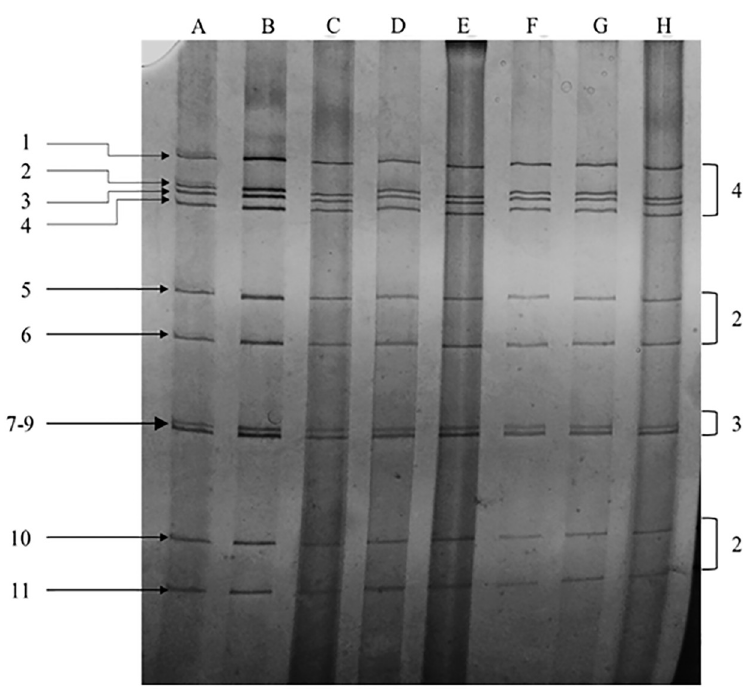
Fig 1. Electropherogram of rotavirus strains isolated from diarrhoeic calf samples in Bangladesh. 1–11, segments of RNA. The genomic RNA segments migration pattern of 4:2:3:2, typical of group A rotavirus was observed in polyacrylamide gel, where segments 7, 8, and 9 moved in a triplet. Segments 1–4, respectively, encode structural protein VP1-VP4, Segemnts 6 and 9 encode structural protein VP6 and VP7, respectively. Segments 5, 7, 8 and 10 encode nonstructural protein NSP1, NSP3, NSP2 and NSP4, respectively. Segment 11 encodes NSP5 or NSP 6. Lane A-H, Rotavirus strains isolated from diarrheic calf samples.